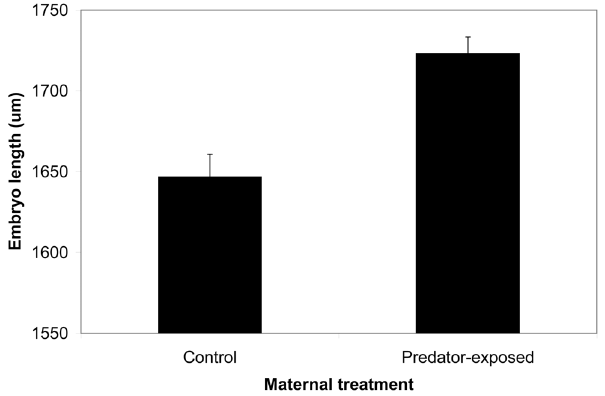
Figure 3. Embryos of stickleback mothers exposed to preda- tion risk were longer than embryos of control mothers. Three days post-fertilization embryos of control mothers (n=127 embryos) and mothers that were chased with a model predator (n=388 embryos) were measured along the anterior-posterior axis. Embryos of predator- chased mothers were significantly longer than control mothers (F 1,14.4 =5.241, p=0.038).